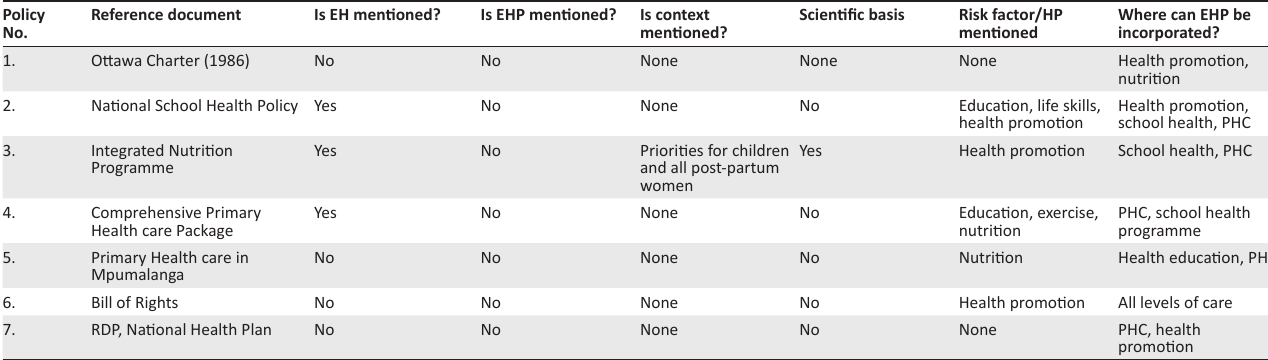
TABLE 6: Provincial level documents obtained for analysis. Policy